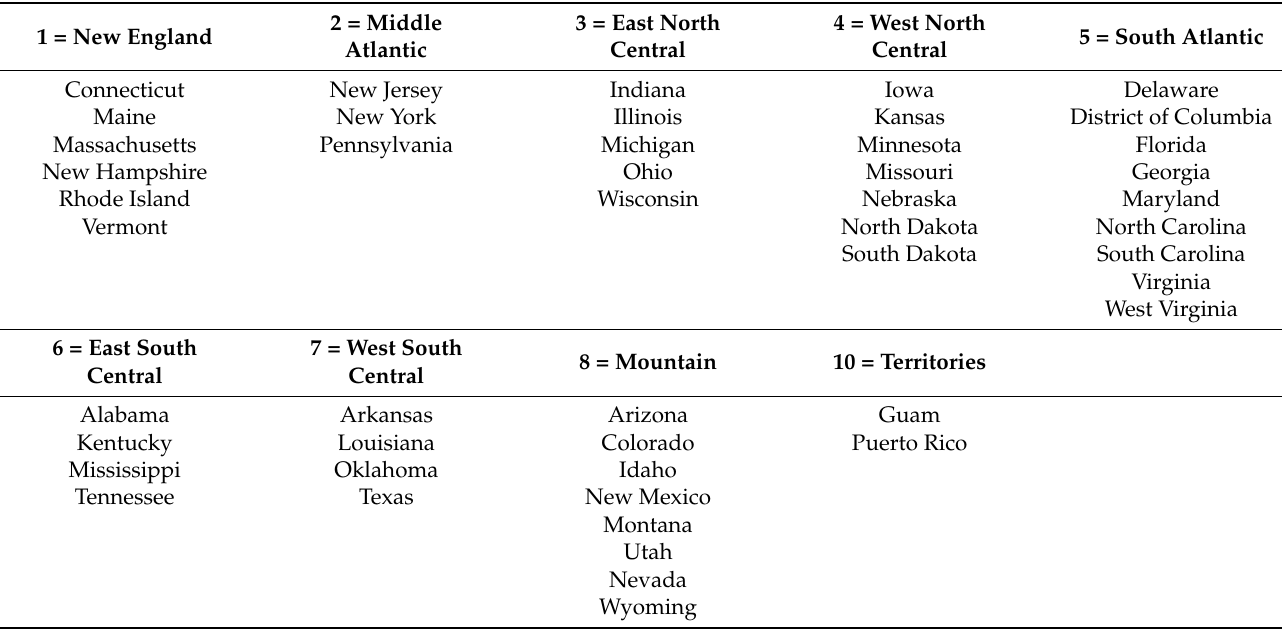
Table 1. Census divisions used for estimating geographical impact on